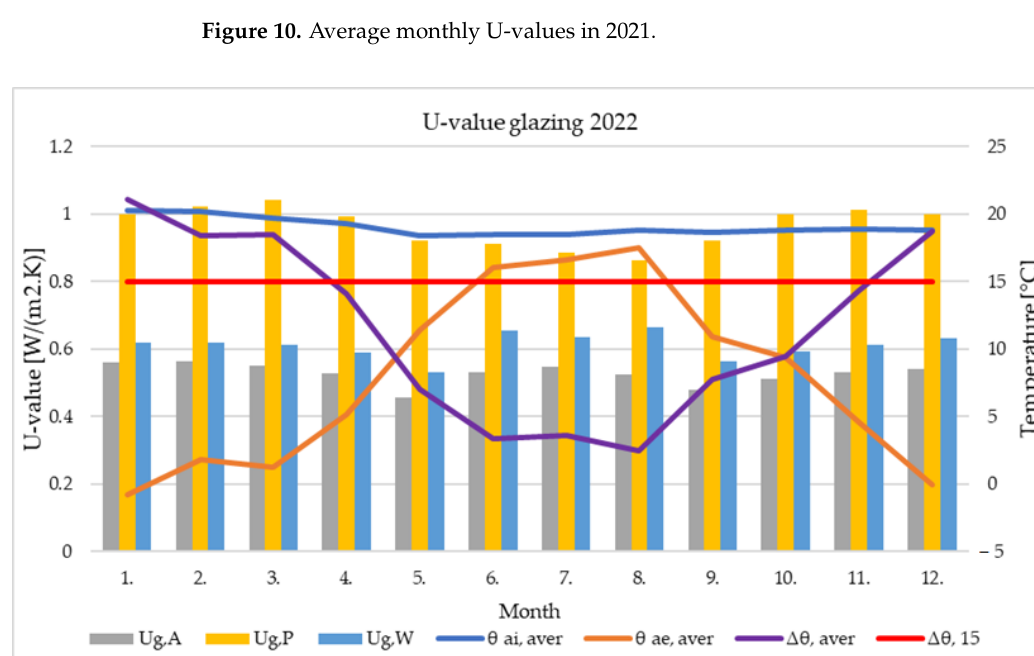
Figure 11. Average monthly U-values in 2022.